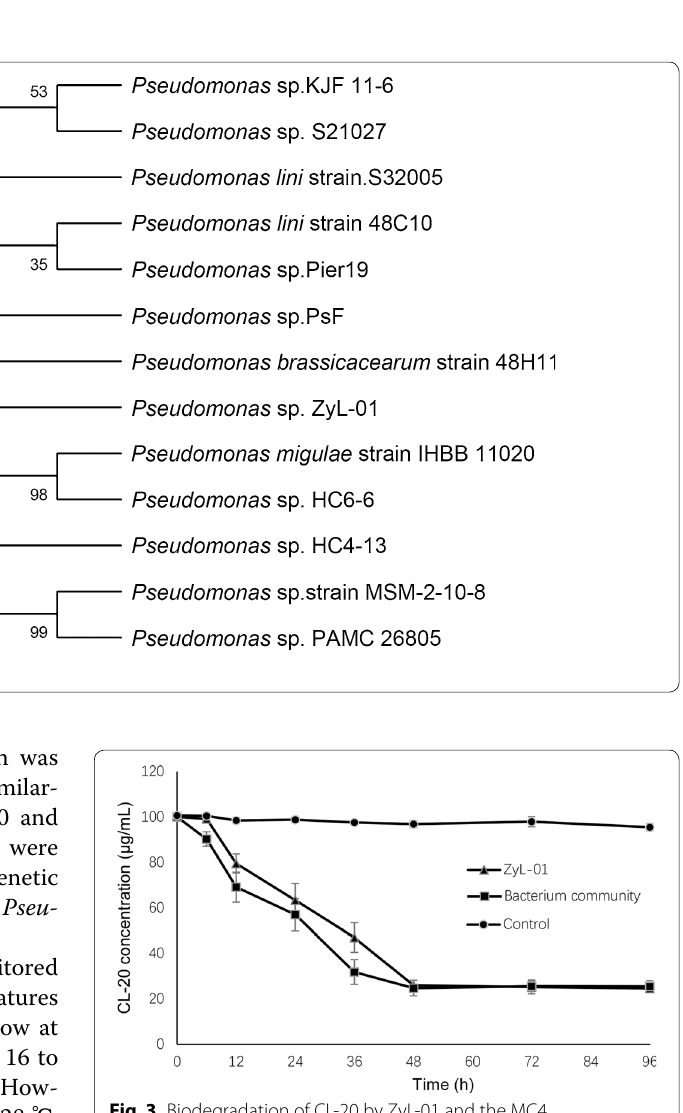
Fig. 3 Biodegradation of CL-20 by ZyL-01 and the